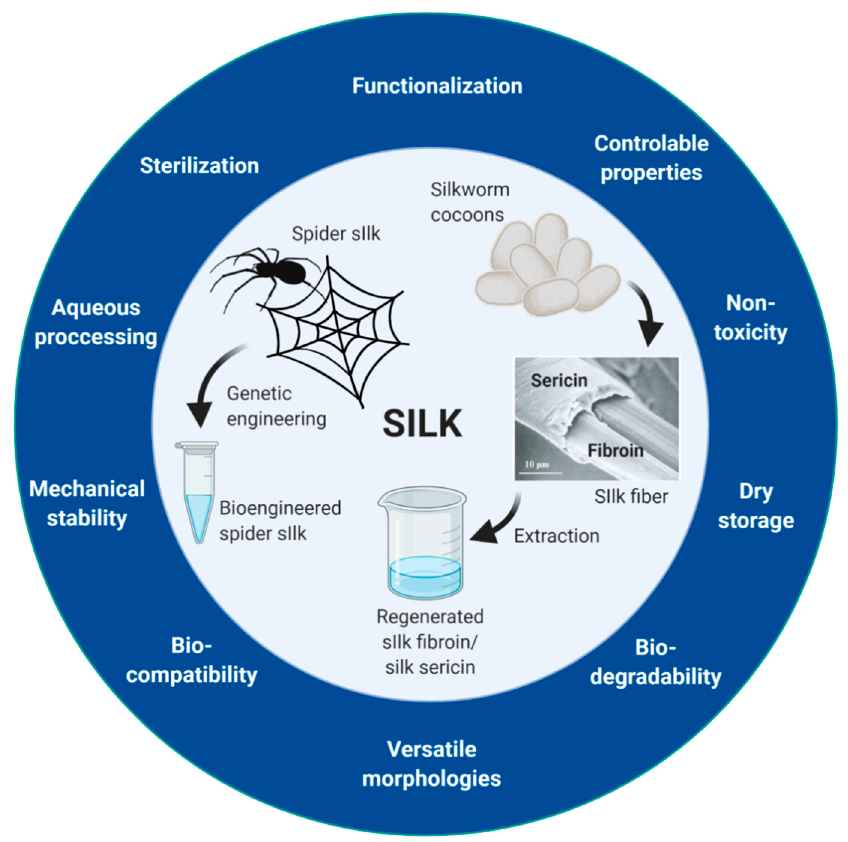
Figure 1. Key advantageous properties of silk proteins for biomedical applications and overview of the origin of silk proteins. Picture presenting the composition of silkworm silk fiber was reproduced with permission [103]. Created with BioRender.com accessed on 28 June 2021.